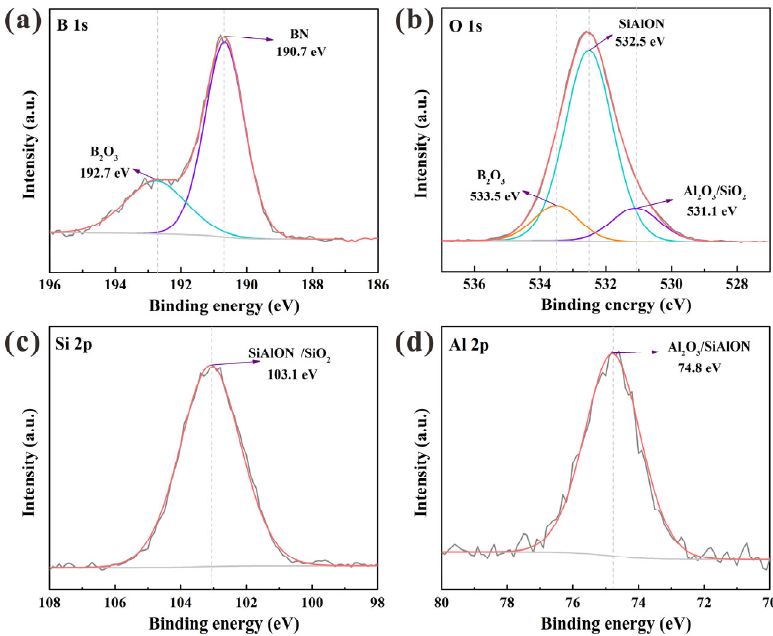
Fig. 12 XPS spectra of wear debris of PcBN/hBN fibrous monolithic ceramics after sliding at 1000 ℃